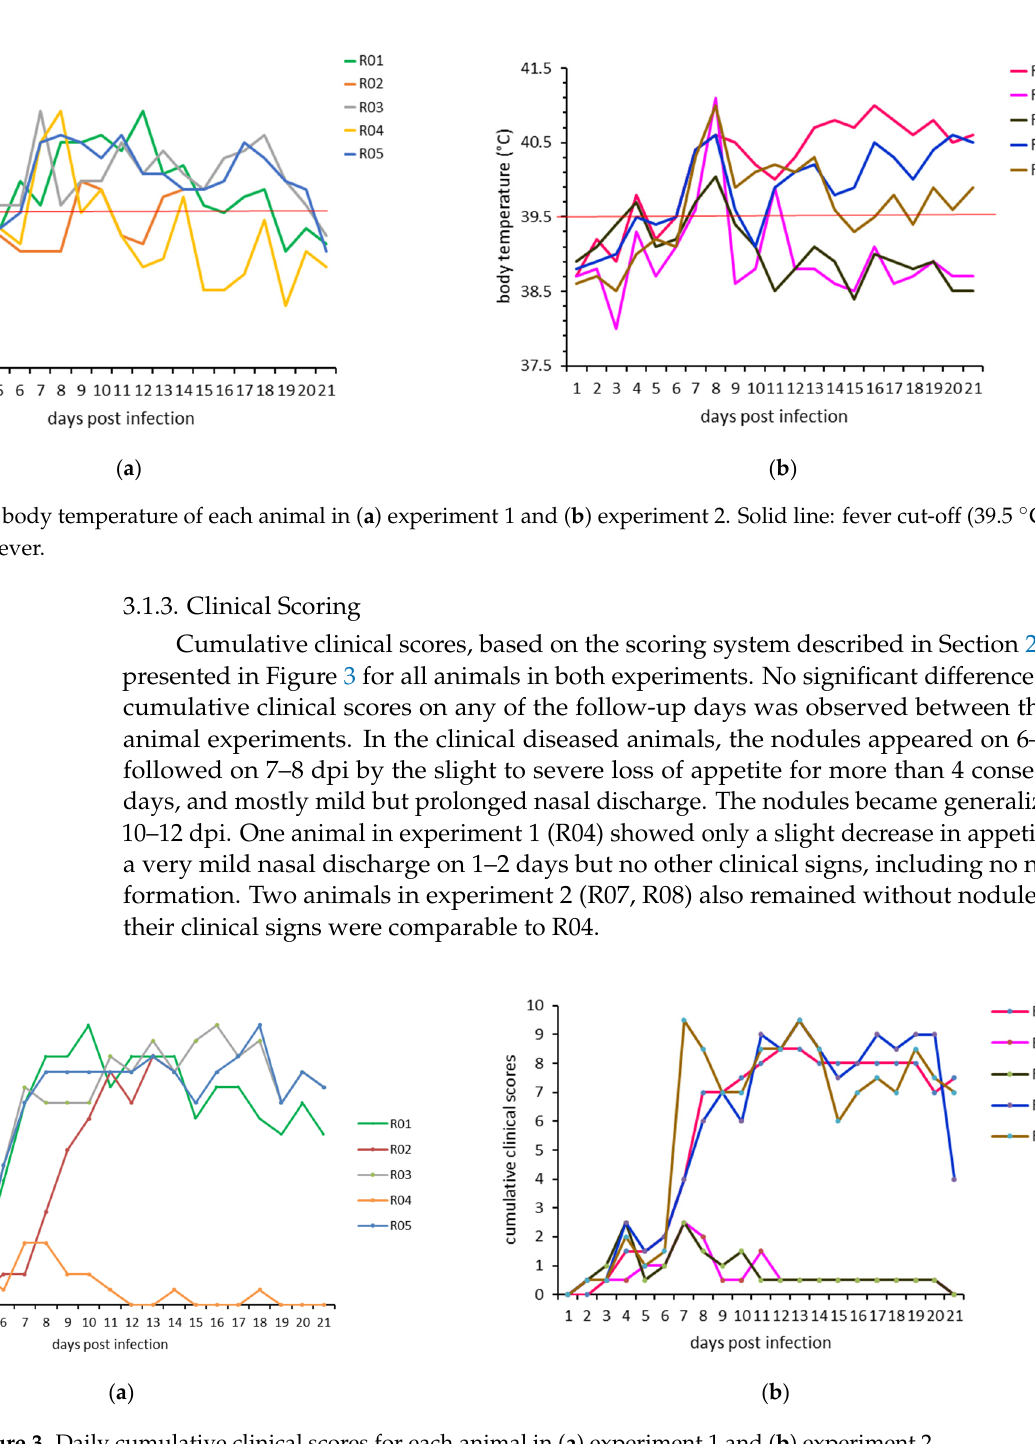
Figure 3. Daily cumulative clinical scores for each animal in ( a ) experiment 1 and ( b ) experiment 2.